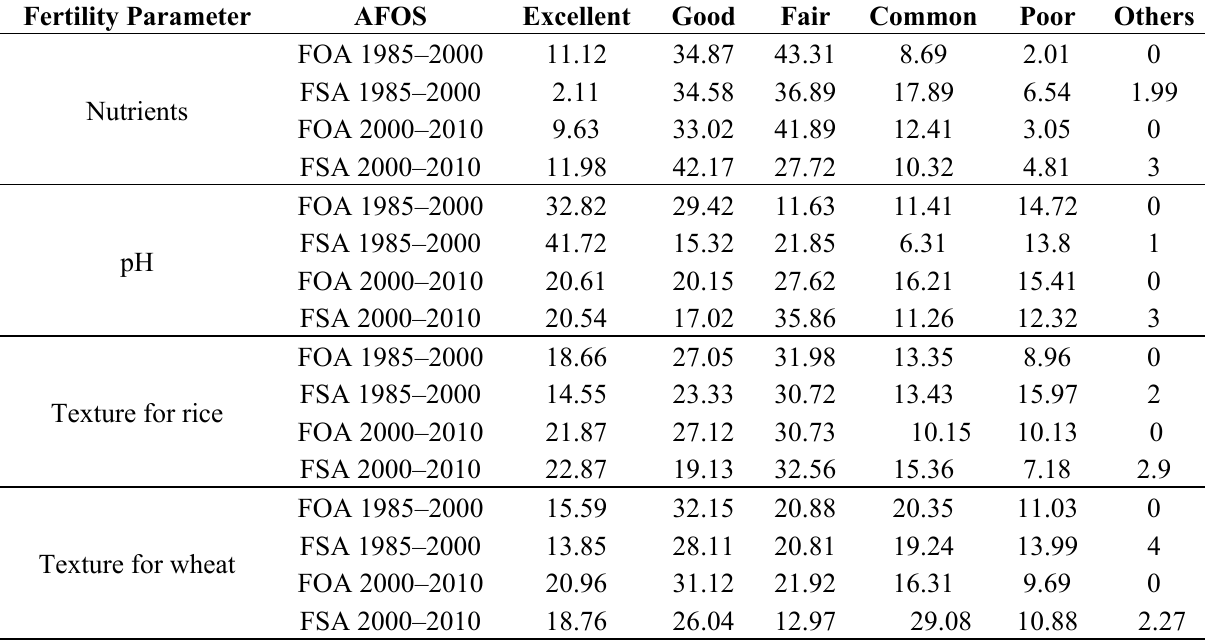
Table 5. The percentage of AFOS soil fertility